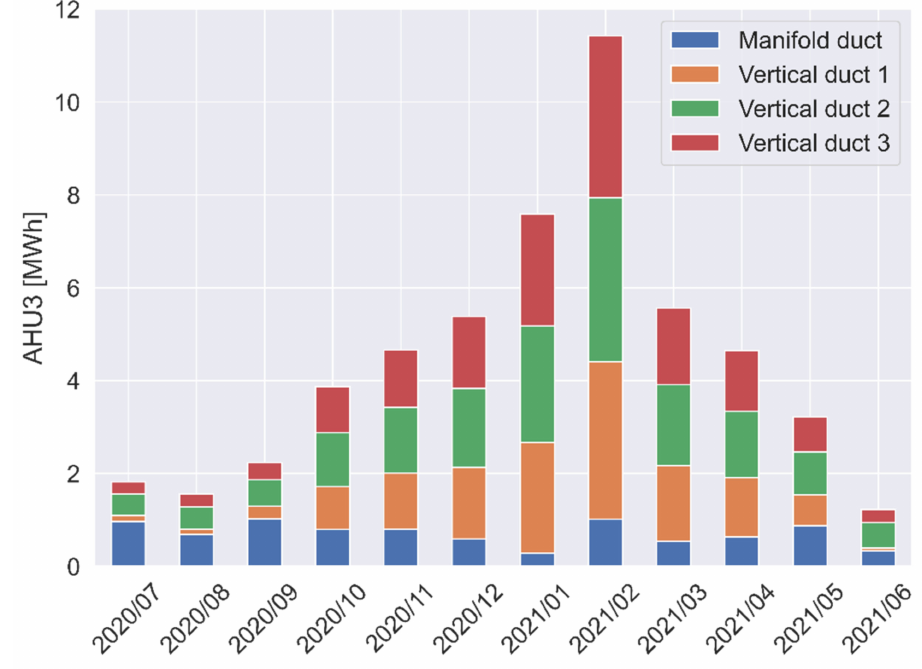
Figure 23. AHU3: monthly energy delivered by level.